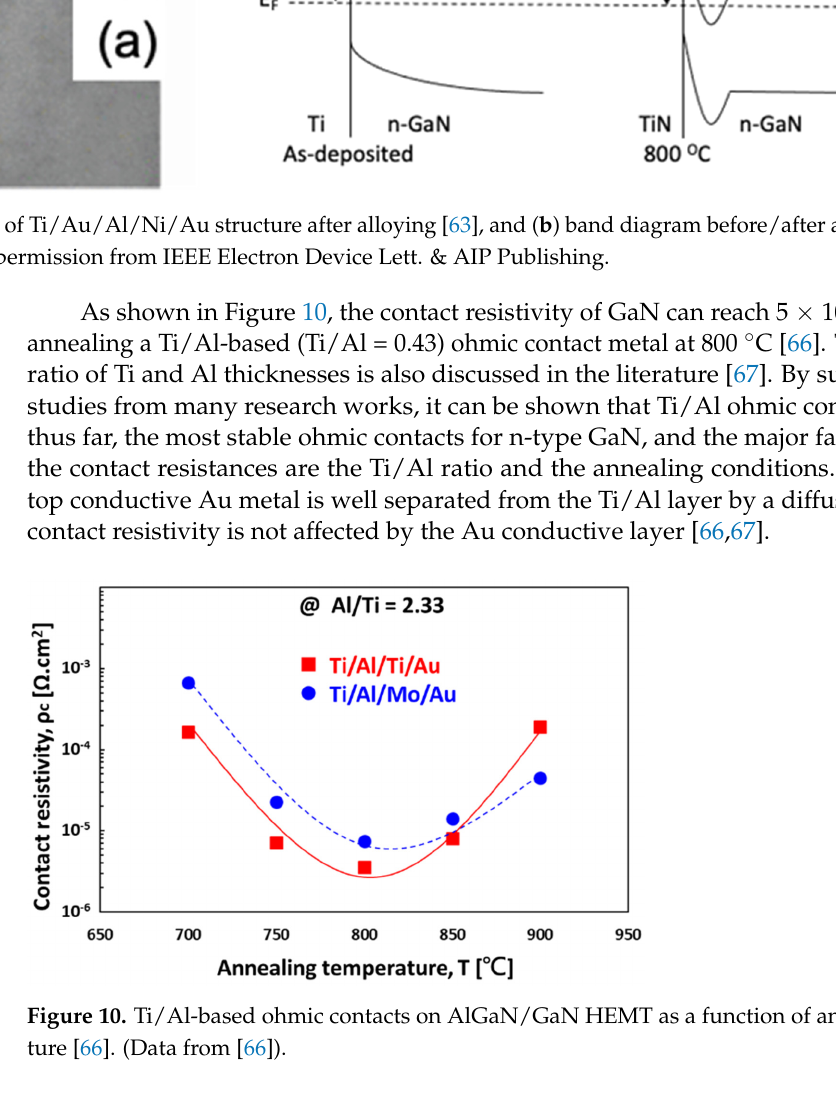
Figure 10. Ti/Al-based ohmic contacts on AlGaN/GaN HEMT as a function of annealing tempera- ture [66] . (Data from [66]). 2.3. Schottky Metal Gate The choice of gate metal also has significant impacts on the performance and relia- bility of GaN HEMTs. In the structure of a typical GaN HEMT, there is a wide-bandgap AlGaN barrier layer between the gate metal and the GaN channel. The gate metal forms a Schottky contact on the AlGaN barrier layer which can control the polarization charge density at the AlGaN/GaN interface. The charge density of the heterostructure and the drain current is controlled by modulating the Schottky contact with the applied gate volt- age. An excessive gate leakage current is not allowed for HEMT devices because it could result in undesired power consumption at the gate or incomplete channel closure. As most GaN HEMTs are “normally on” devices owing to the intrinsic characteristic of the